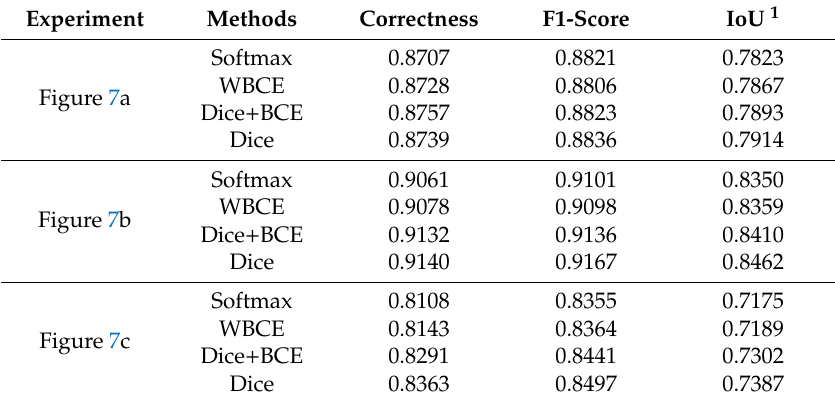
Softmax 0.9061 0.9101 Figure 7b